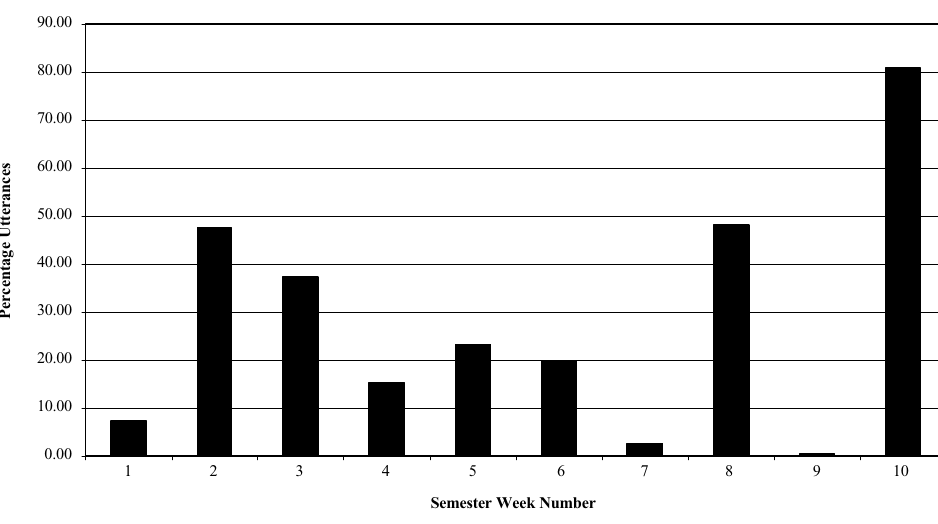
Figure 3. Percentage of utterances relevant to the module, versus week